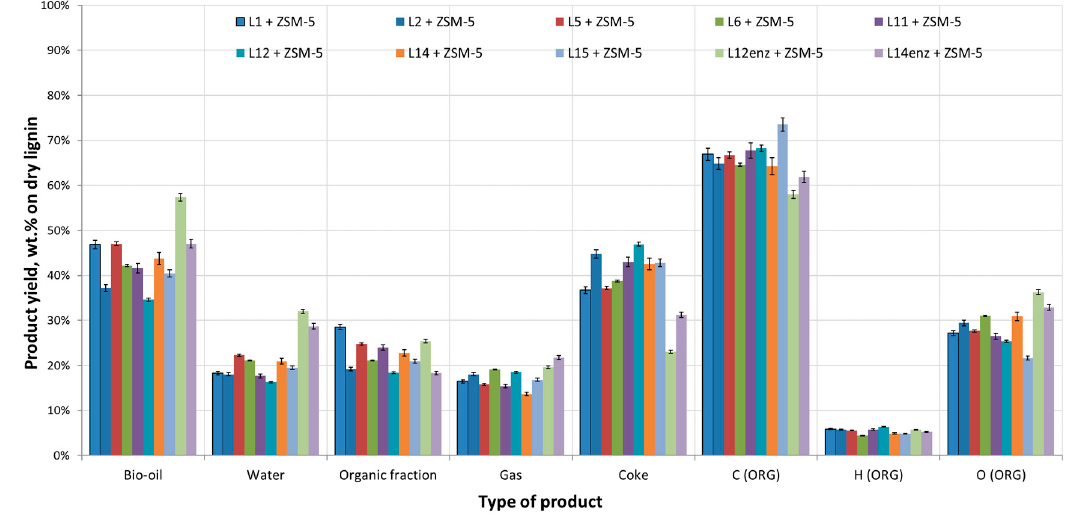
Figure 2. Product yields and bio-oils elemental analysis (dry basis) from catalytic pyrolysis of organosolv-derived beechwood lignins.